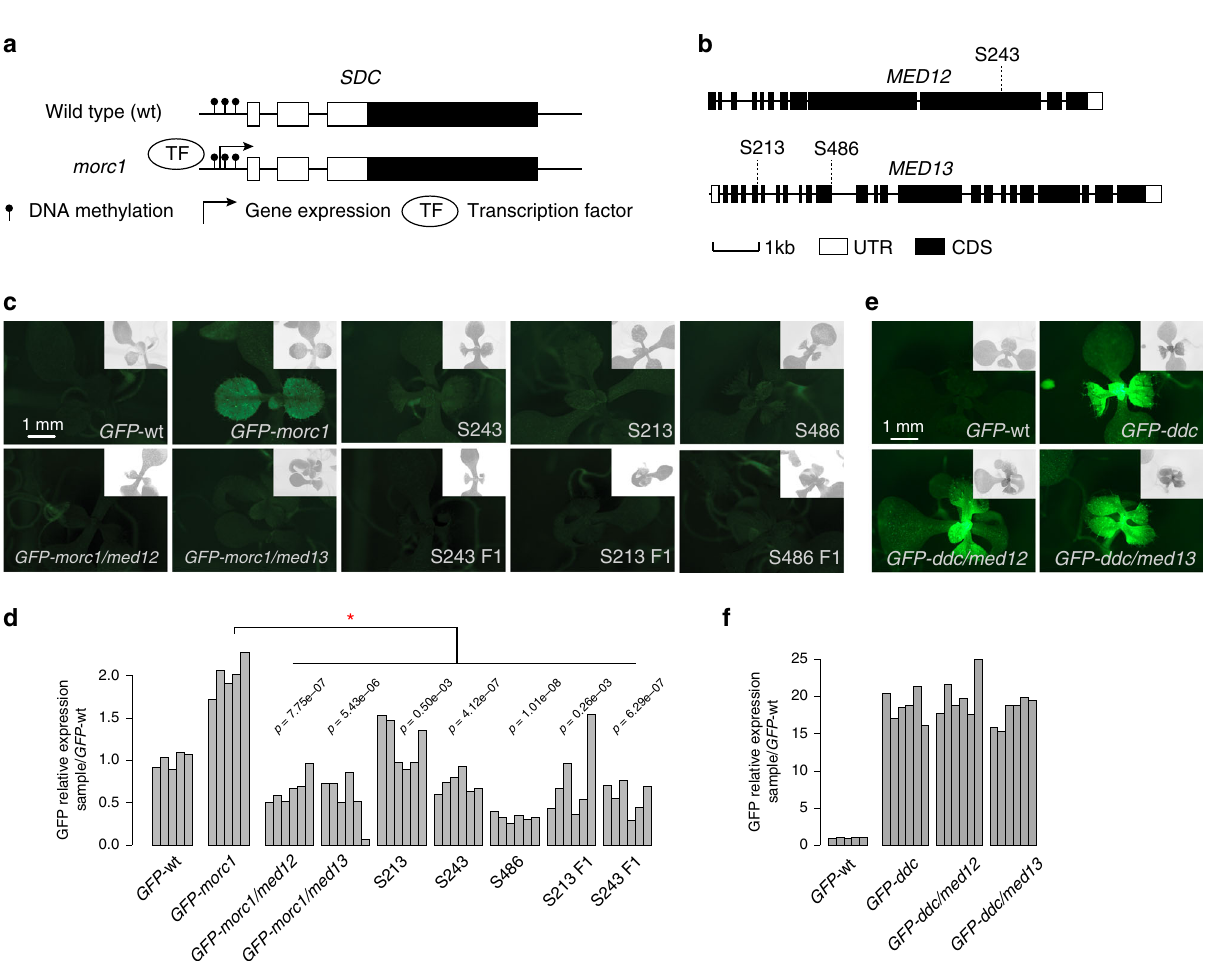
Fig. 1 Identi fi cation of med12 and med13 mutations as morc1 suppressors. a Schematic diagram of SDC gene structure and its transcription status in different genetic backgrounds. Open rectangle represents the SDC 5 ’ -untranslated region (5 ’ -UTR). Filled rectangle represents the SDC coding sequence (CDS). b Schematic diagram of the Arabidopsis MED12 and MED13 gene structures with the position of each EMS mutation illustrated. Data display conventions as in a . c GFP fl uorescence of plants in different genetic backgrounds. GFP -wt and GFP-morc1 are plants carrying the SDC:GFP transgene in wild- type and morc1 mutant backgrounds, respectively. S243, S213, and S486 are med12 and med13 EMS alleles in the GFP-morc1 background. GFP-morc1/med12 is the med12 CRISPR-CAS9 allele re-created in GFP-morc1 background. GFP-morc1/med13 is the med13 T-DNA allele re-created in GFP-morc1 background. S243-F1 is the F1 resulting from the cross between the CRISPR-CAS9 re-created GFP-morc1/med12 and S243; S213-F1 and S486-F1 are the F1s resulting from the crosses between the re-created GFP-morc1/med13 and S213, S486, respectively. Images show 8-day-old seedlings. The auto- fl uorescence (gray) from chloroplasts are shown at the top-right corner of each image. d Real-time PCR quanti fi cation of SDC:GFP expression compared between different genetic backgrounds. Each vertical bar represents one biological replicate. A minimum of fi ve biological replicates were analyzed for each mutant background. Red asterisk represents statistically signi fi cant difference between the groups under comparison (Student ’ s t test, two-sided). e GFP fl uorescence of plants in different genetic backgrounds. GFP -wt and GFP-ddc are plants carrying the SDC:GFP transgene in wild-type and ddc mutant backgrounds, respectively. GFP-ddc/med12 mutant is the med12 CRISPR-CAS9 allele re-created in GFP-ddc background. GFP-ddc/med13 mutant is the med13 CRISPR-CAS9 allele re-created in GFP-ddc background. f Real-time PCR quanti fi cation of SDC:GFP expression compared between different genetic backgrounds. Data display conventions as in d . Source data underlying d , f are provided as a Source data fi